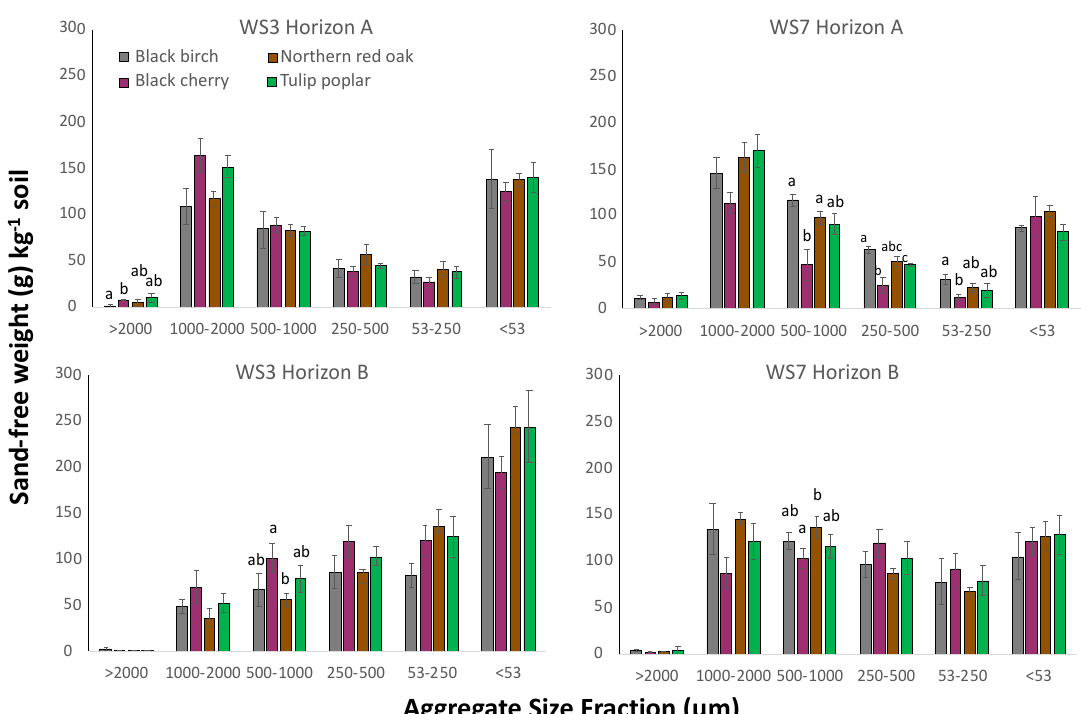
Figure 2. Sand-free weight within each aggregate size class by tree species in A-horizon and B-horizon by watershed (WS3-FERT and WS7-REF): for each horizon within each watershed, bars with different letters within each aggregate size fraction are significantly different according to Kruskal–Wallis pairwise means comparison ( p < 0.05).